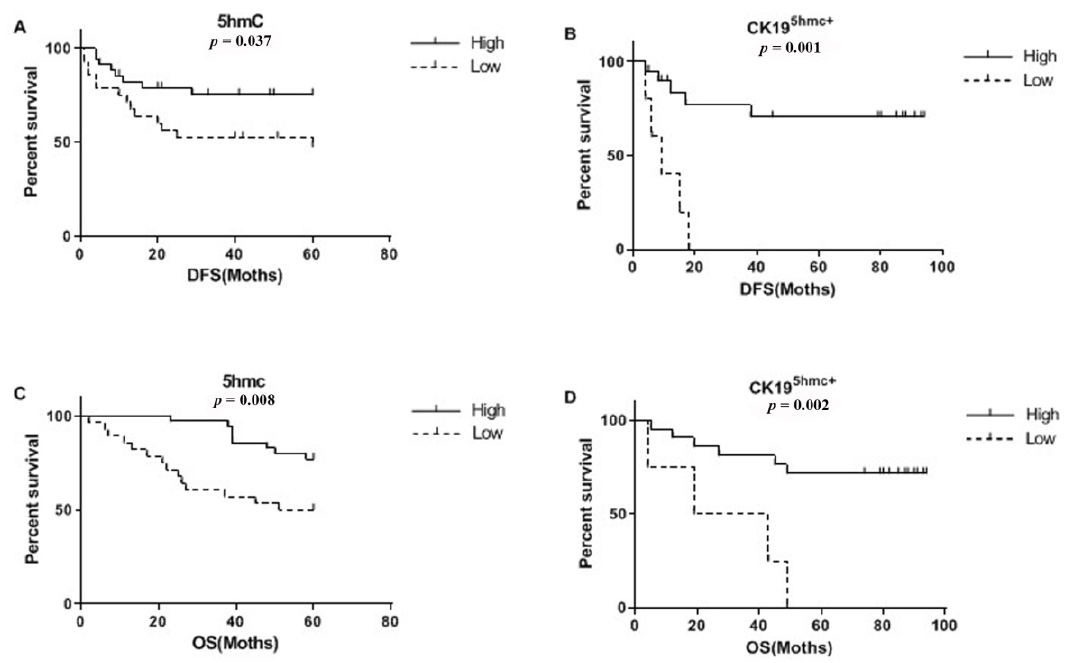
Figure 4. Kaplan–Meier curves which compares DFS and OS of 5hmC content and CK19 5hmC+ content from genomic DNA. Patients having low 5hmC content or CK19 5hmC+ content in SHCC tissues exhibited poor DFS ( A , B ) and OS ( C , D ) relative to counterparts having increased 5hmC and CK19 5hmC+ levels. Table 2. Univariate cox analysis on DFS and OS of SHCC.